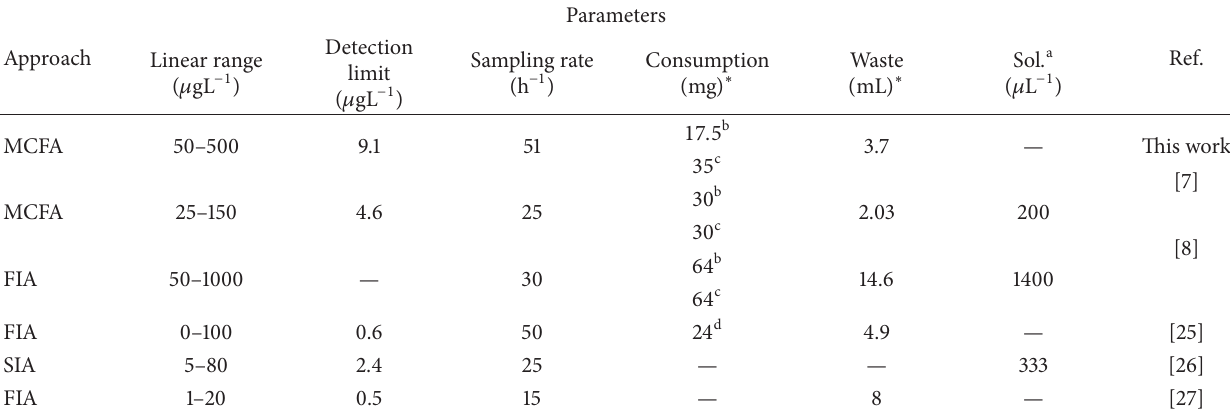
Table 5: Performance